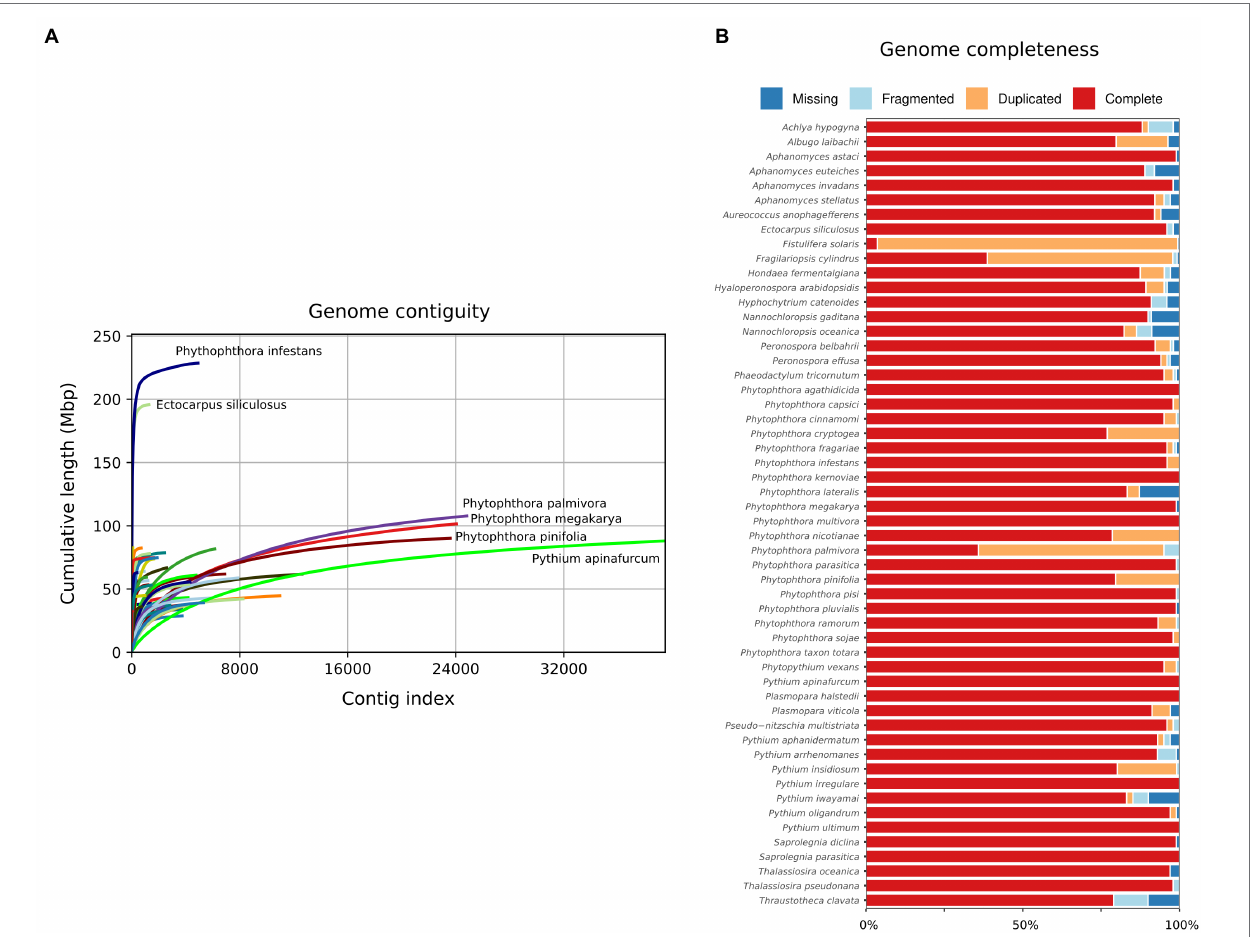
FIGURE 3 | Statistics for 54 published Stramenopile genome sequences including 42 oomycetes. (A) Genome accumulation curves derived from Quast (Gurevich et al., 2013), showing cumulative genome size when contigs are ordered from large to small. X-axis represents the number of contigs, and Y-axis represents genome size. (B) Presence of near-universal single copy orthologs in the genomes, as determined by BUSCO. Species are in alphabetical order. Colors indicate the completeness of the detected BUSCO genes. For further details on the genome sequences used for these analyses see Rodenburg et al.